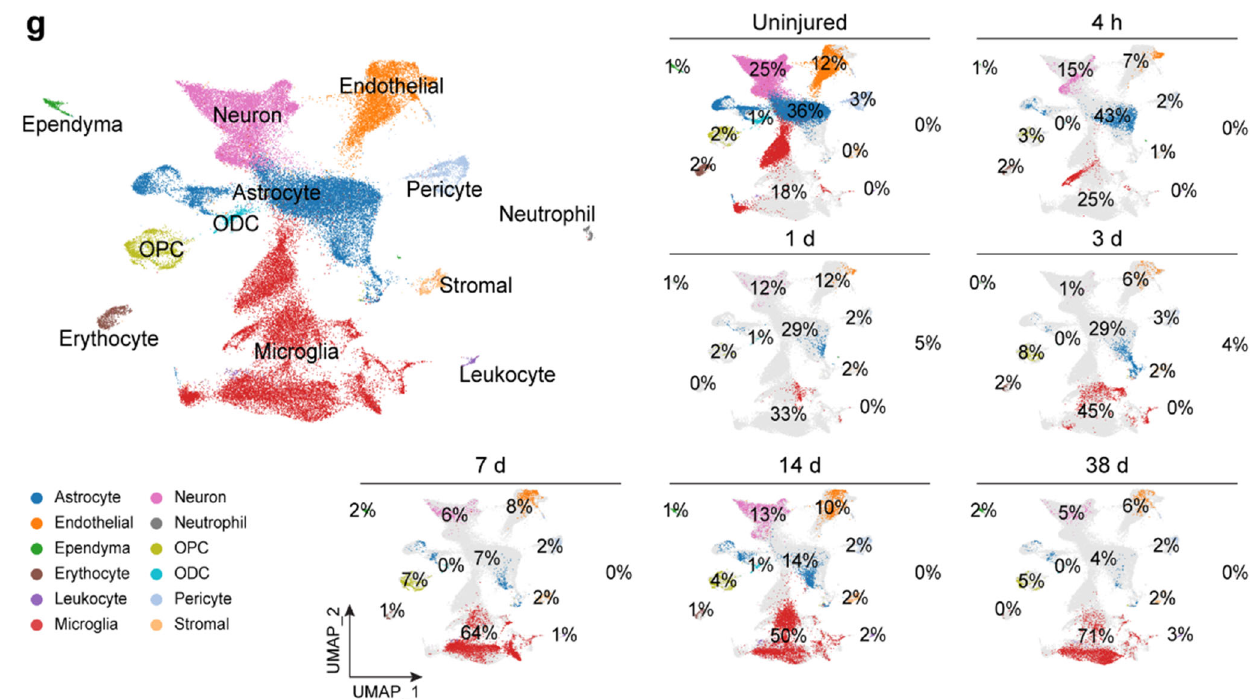
Fig. 2 g UMAP visualization plot of 59,558 spinal cord cells sequenced from all samples, color-coding de fi ned 12 major cell types based on signature gene expression. The panels on the right show the proportion of each cell type at each time point before and post SCI